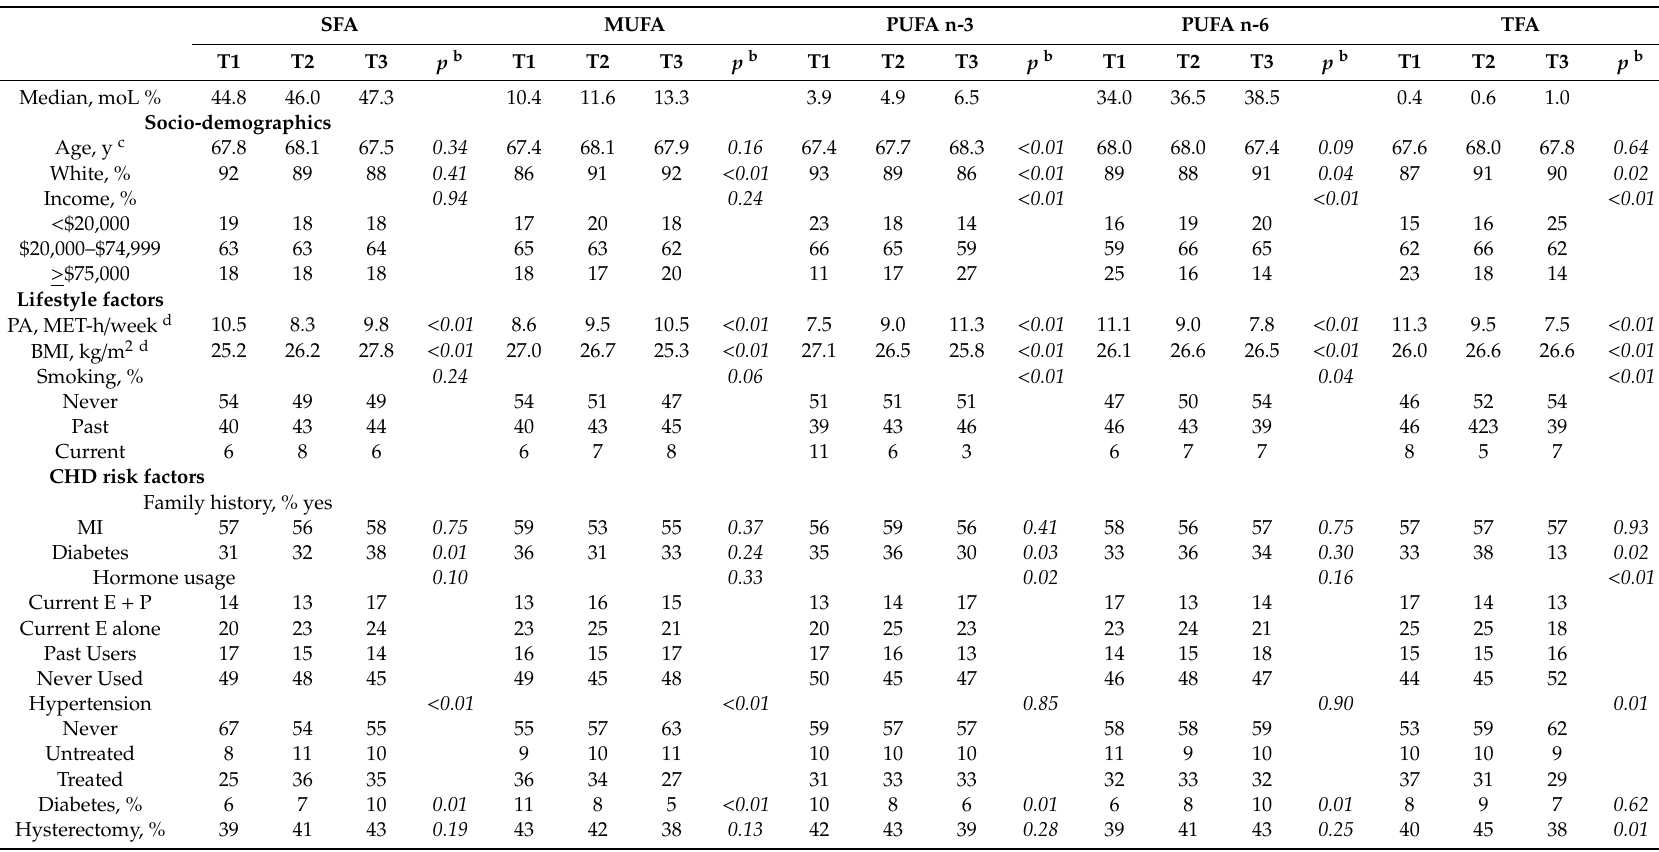
Table A1. Relationship of plasma phospholipid fatty acids a and socio-demographic, lifestyle, and CHD risk factors in the matched case-control study of the